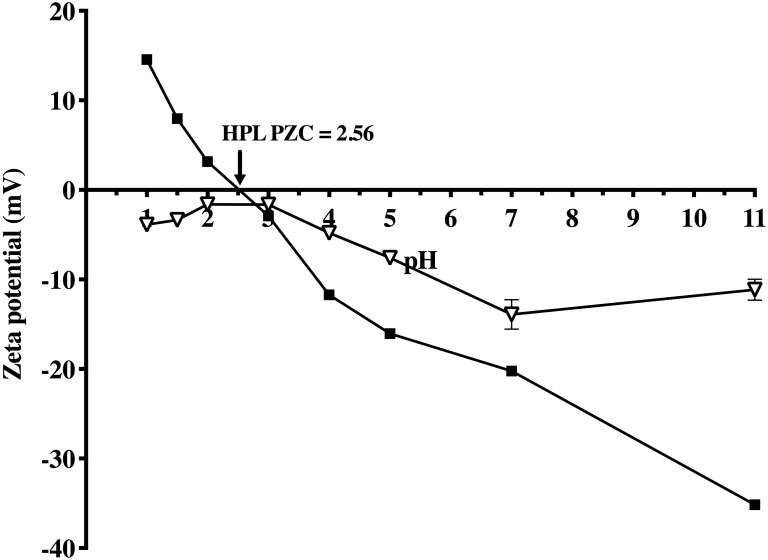
Zeta potential of HPL (■) and AO74 (▽) as a function of pH.